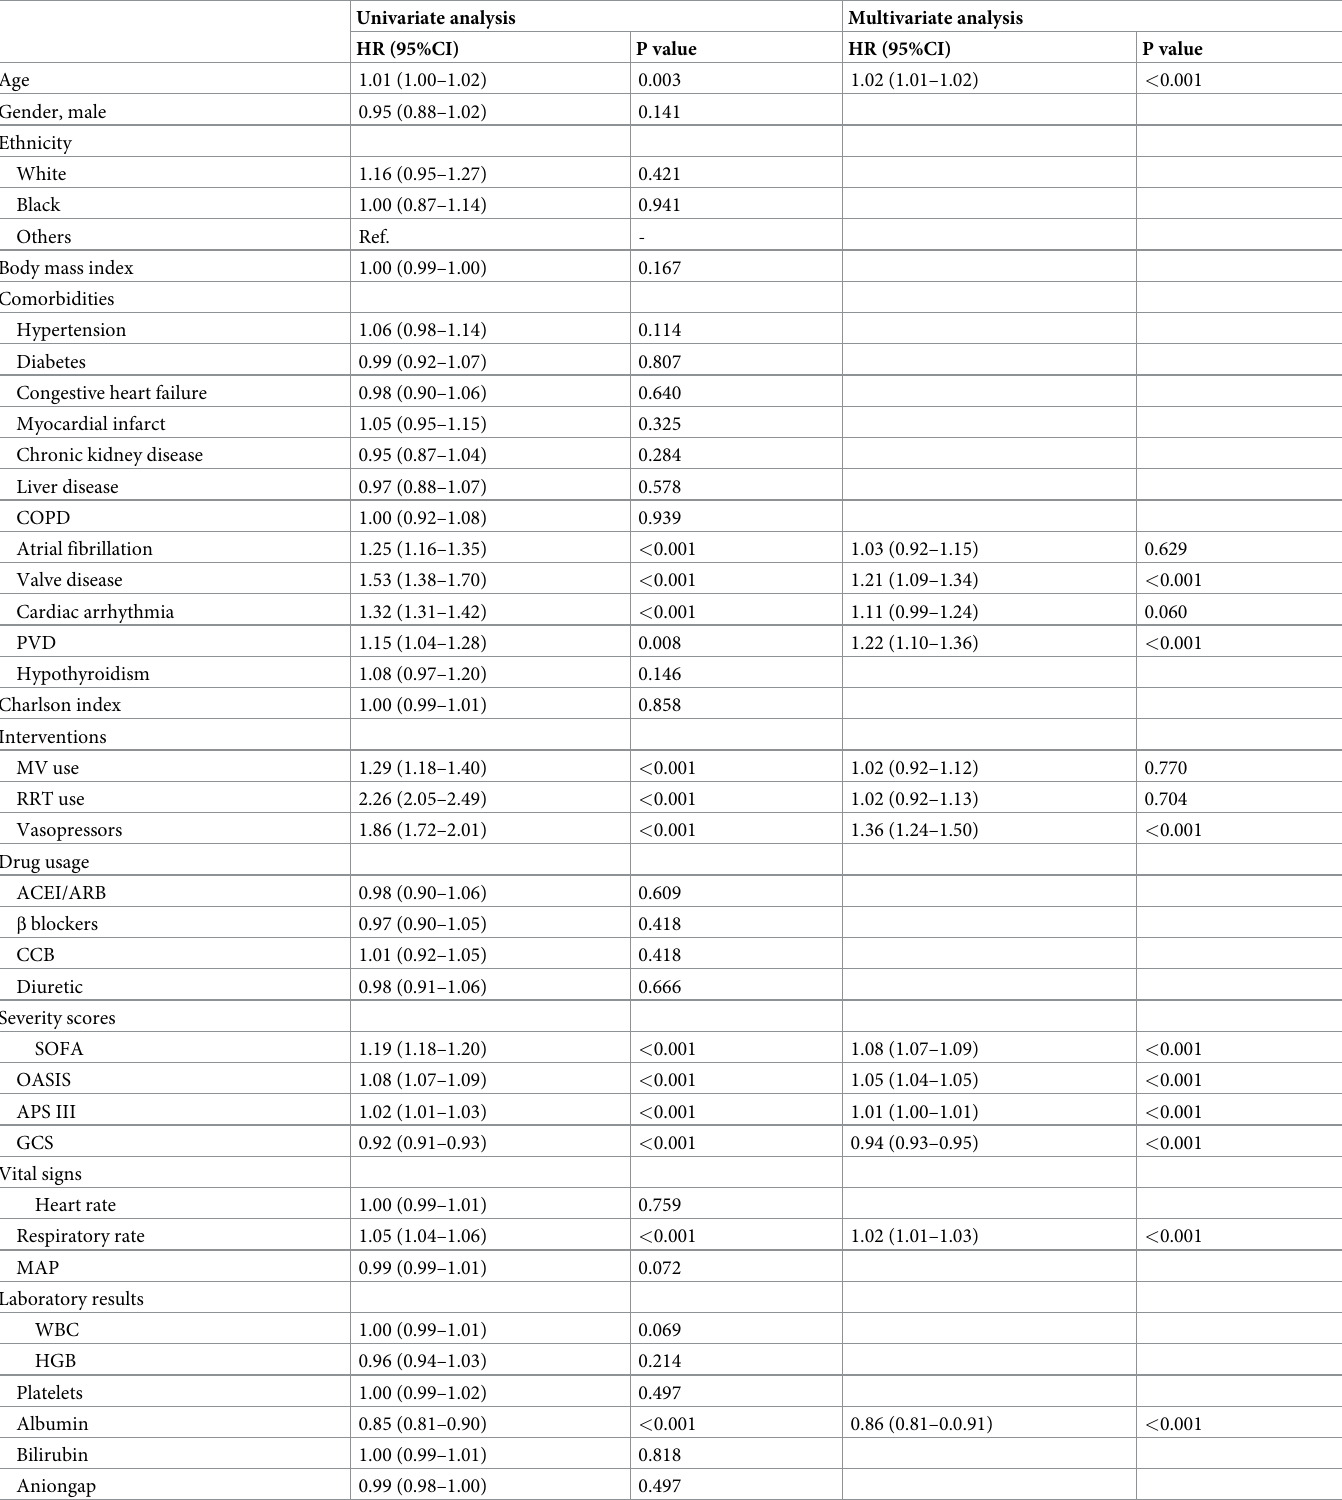
Table 3. Cox analyses of factors associated with in-hospital mortality in training